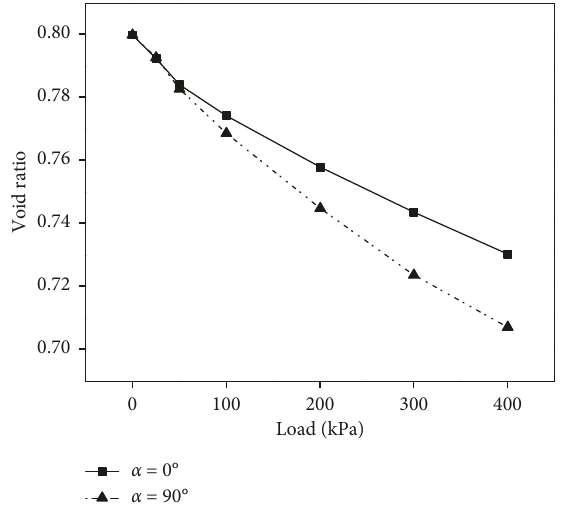
Figure 8: The e-p curve of vertical specimen and horizontal specimen.